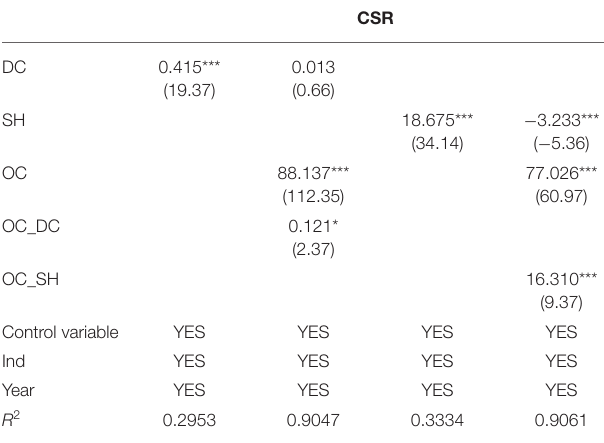
TABLE 5 | Results of moderating